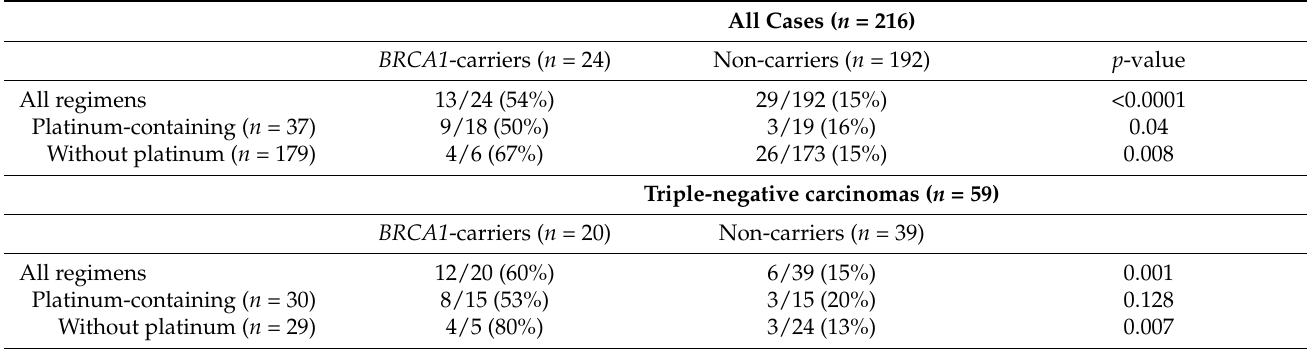
Table 2. The pCR rate in different patient